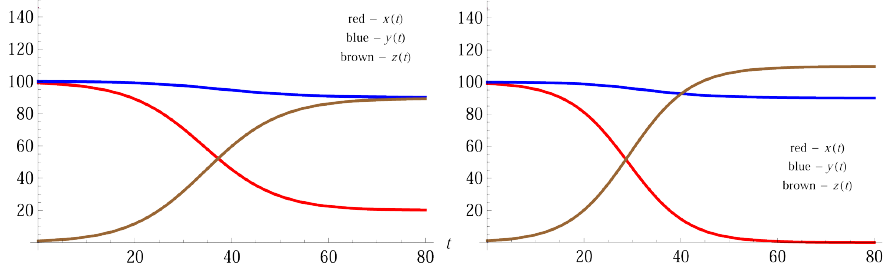
Figure 3. Time series of system (3): b , 0 vs. b = 0 ( a = 2 . 73973 · 10 − 6 , c = 0 . 0015 , m = 0 . 0000328767 , n = 0 . 09 , p = 0 . 001; left: b = 0 . 03 , d = 0 . 120047; right: b = 0 , d = 0 . 0900362; initial conditions: x 0 = 99; y 0 = 100; z 0 =